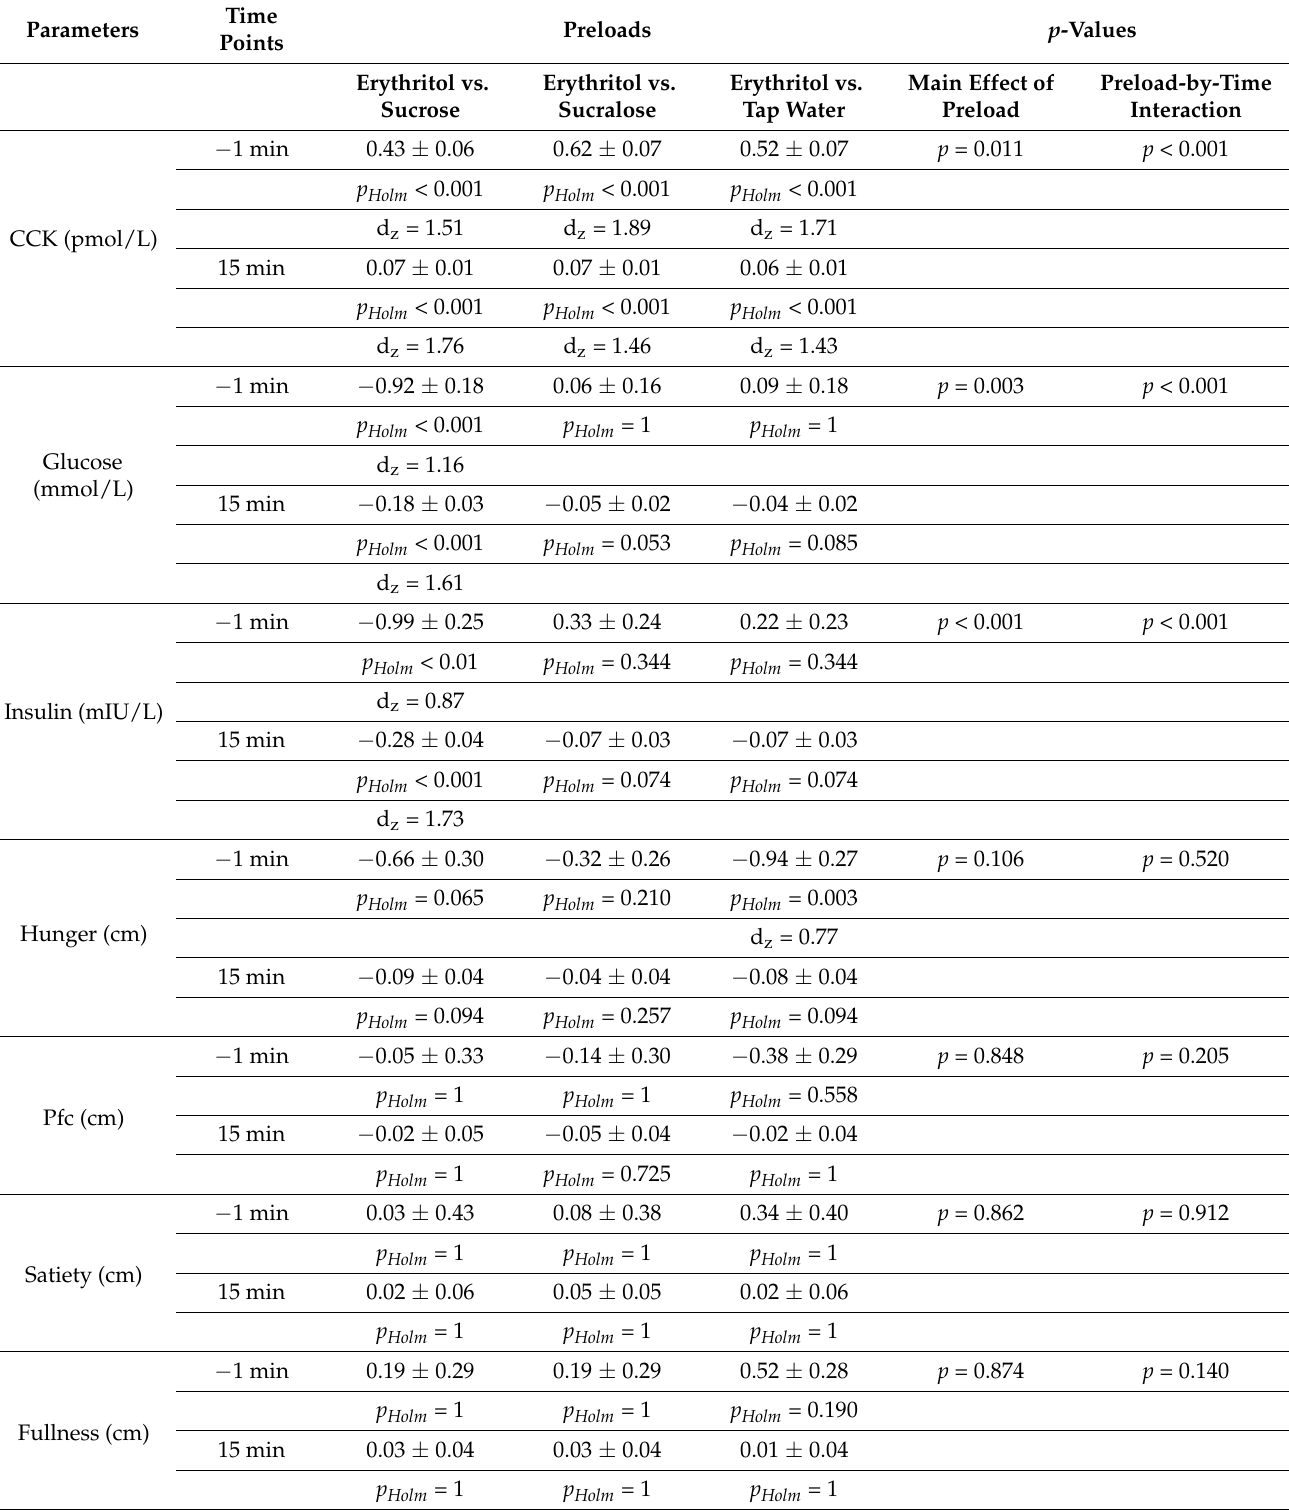
Table 2. Effects of preloads containing either 50 g erythritol, 33.5 g sucrose, 0.0058 g sucralose, or tap water on CCK, glycemic control, and appetite-related sensations in 20 healthy participants 1